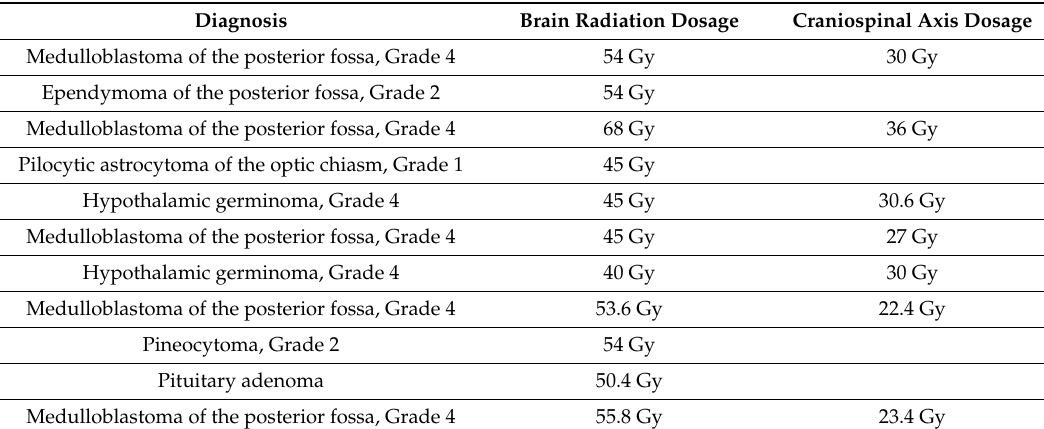
Figure 1. Histology of brain tumors in patients with iatrogenic thyroid disease. Table 1. Radiotherapy